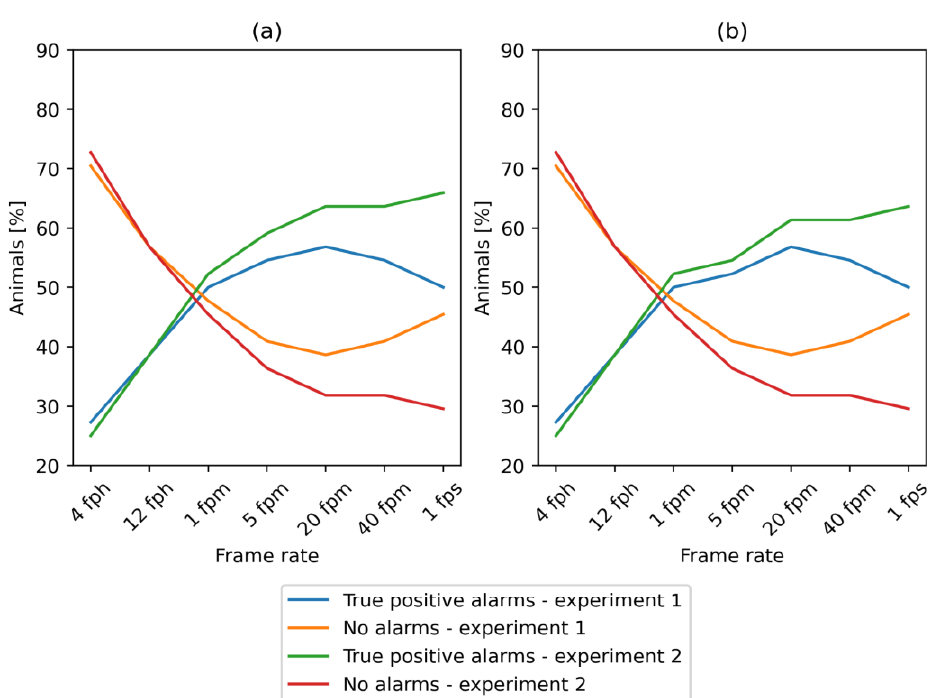
Figure 7. Results of farrowing prediction. Percentage of animals with ( a ) ”First-stage” alarms. ( b ) “Second-stage” alarms.